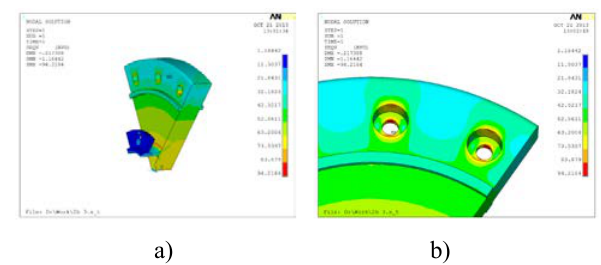
Fig. 7. Equivalent stresses in sector (a) and grinding head holes (b).